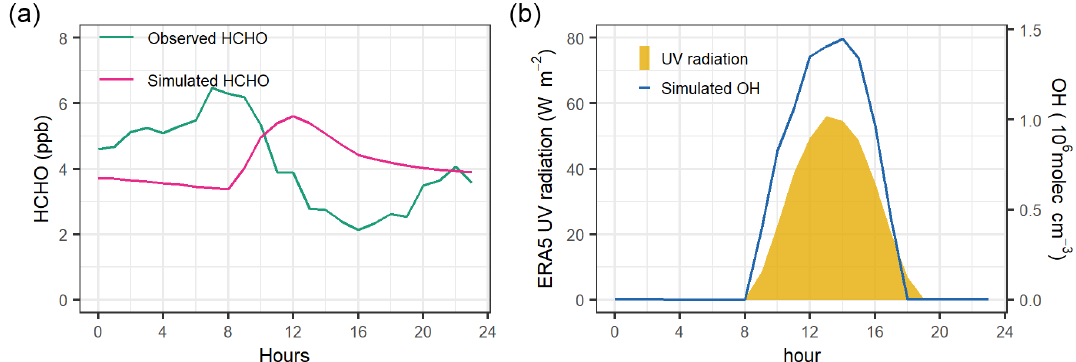
Figure 3. (a) Observed and simulated formaldehyde (HCHO) and (b) the EAR5 UV radiation flux and the simulated OH radical in the box